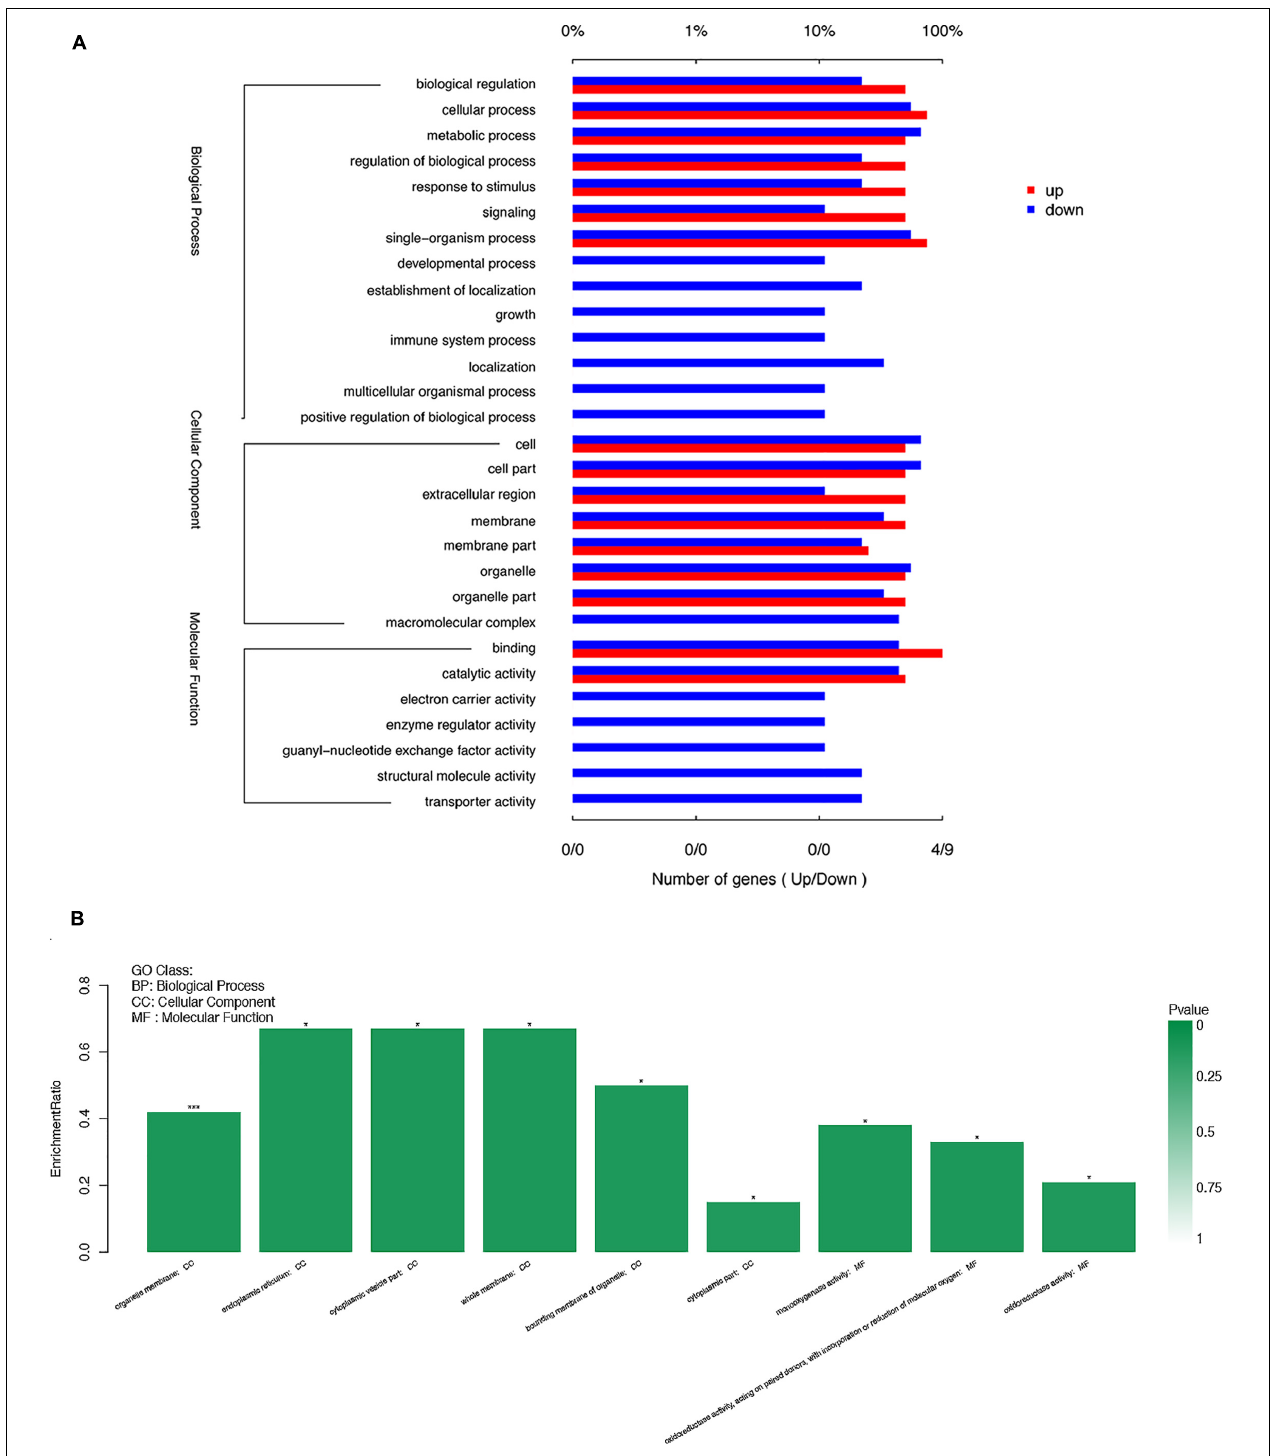
FIGURE 5 | Functional distribution of the differentially expressed genes (DEGs) based on gene ontology (GO) term categorization. (A) Unigenes in each group were annotated in three GO categories: BP, biological process; CC, cellular component; MF, molecular function. The X -axis shows the percentage of the DEGs function categories. and the right of the Y -axis indicates the secondary level of term in the three major categories of GO categories. (B) The significant enrichment of DEGs function. The left of the X -axis shows the enrichment ratio, and the right bar shows the P value ( p value is represented by color). * P < 0.05; *** P < 0.001.